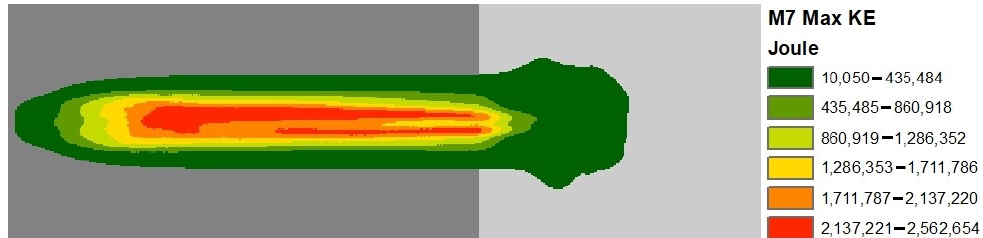
Figure 13. Contours of maximum kinetic energy in